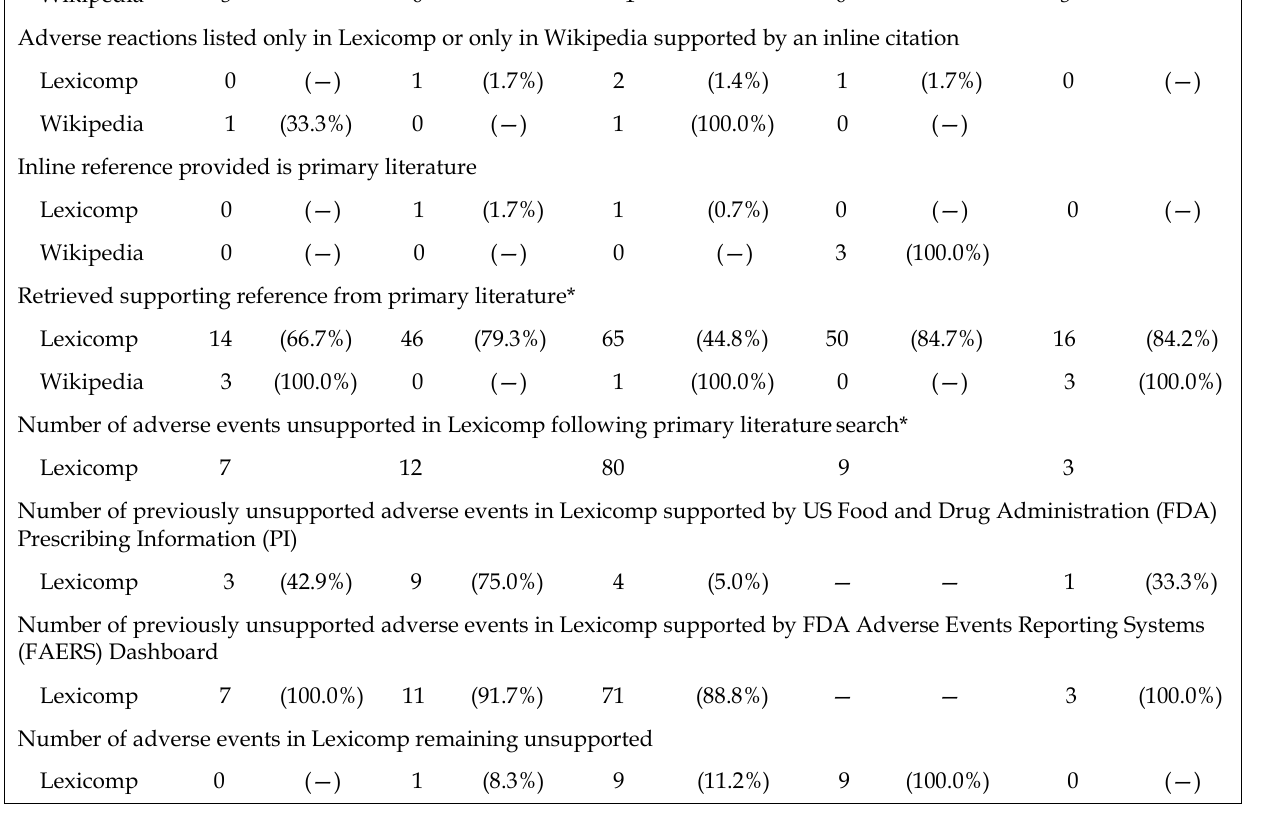
Table 2 Literature search reporting characteristics, systematic reviews sample (n=75) Levothyroxine Atorvastatin Pantoprazole